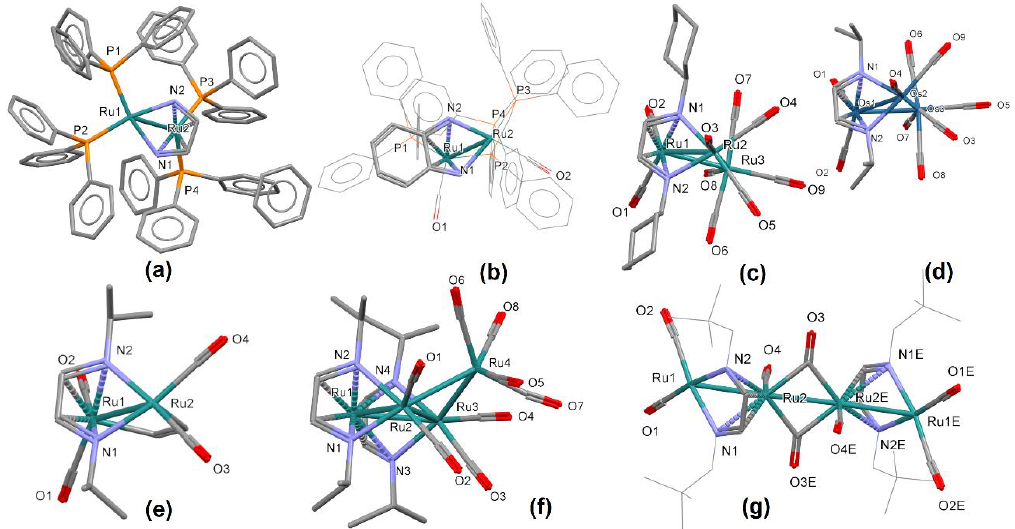
Figure 7. ( a ) The dual mode of coordination exhibited by 1,4-diazabutadiene ligands in binuclear complexes of with Ru. Chelating ligation and pentahapto-like ( η 5 -) bonding [142]. (CSD Refcode FIMNAR); ( b ) cationic part of diruthenium complex with the η 5 coordination mode [122] (CSD Refcode AROQAZ); ( c – f ) coordination mode 8e μ 2 - κ 2 - N,N’: η 2 -C=N: η 2 - C’=N’ of DAB ligands observed